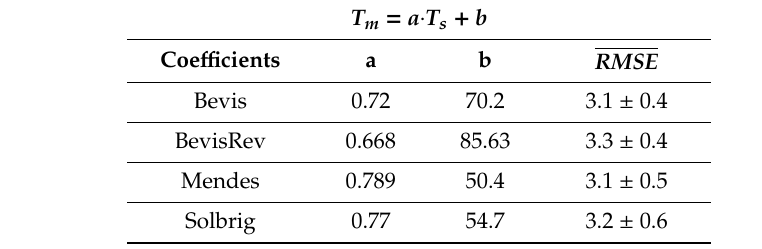
Table 1. Average root mean square error (RMSE) ( RMSE ) of the analyzed coe ffi cients calculated based on 109 RS stations.